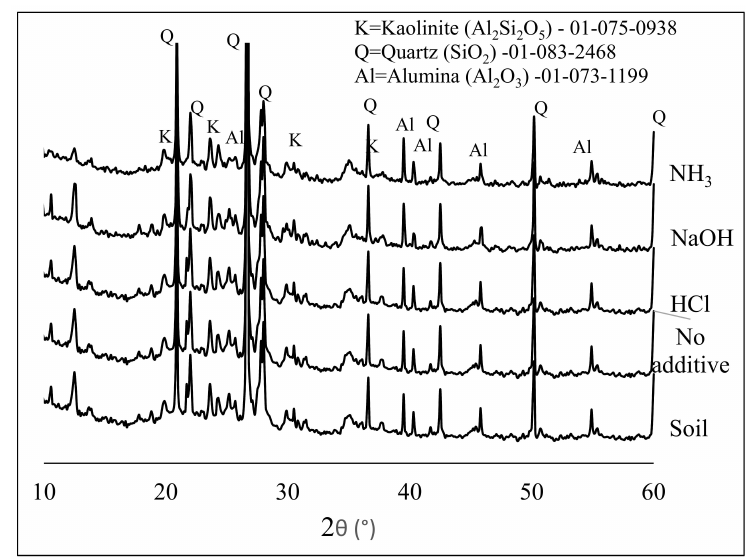
Figure 3. The X-ray Di ff ractometer (XRD) of soil before and after US treatment.